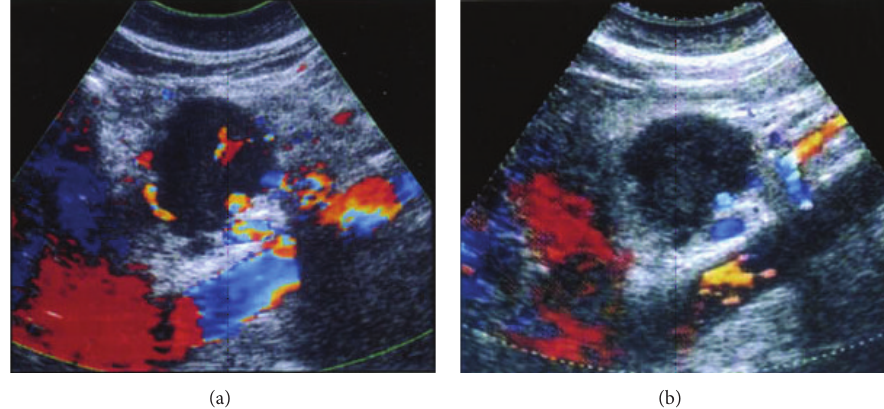
Figure 7: Sonography of pancreatic cancer (a) before and (b) after HIFU therapy showing the enhancement of echogenicity in the tumor but decrease of vascularity, an indicator of coagulative necrosis (used with permission